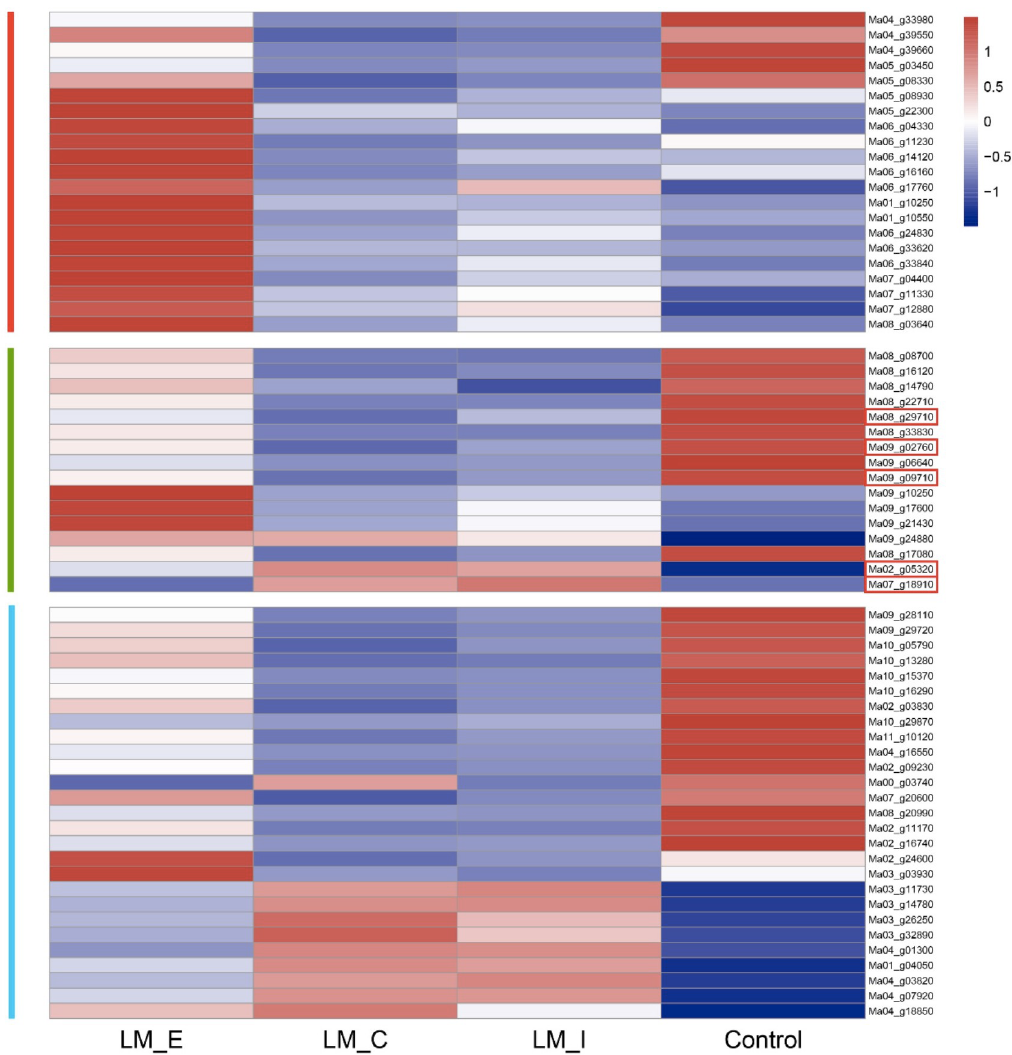
Fig 6. Heatmap generated from the FPKM mean value calculated from three replicates of RNA-seq data. Red represents upregulated genes, and blue represents downregulated genes.